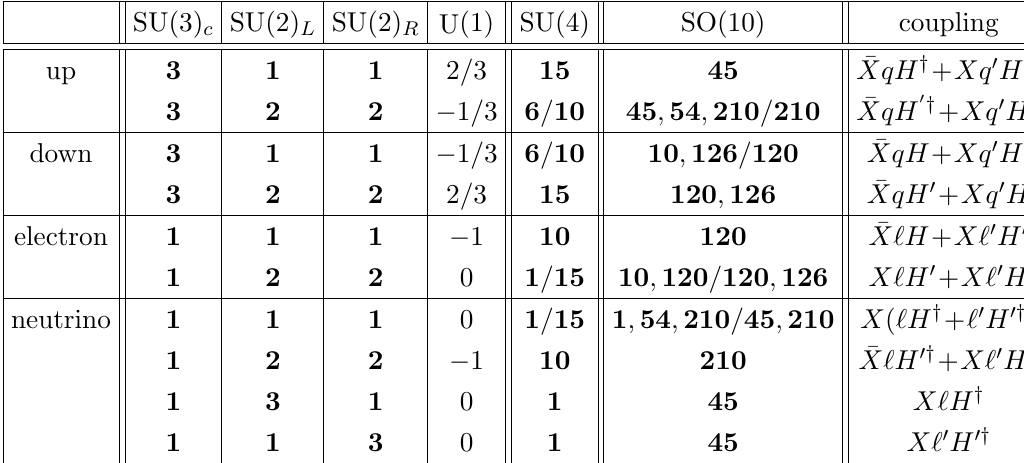
Table 3 . Possible X particles for generating Yukawa couplings in Model A. We also show the embedding of X into the Pati-Salam group SU(4) Here ~ y u;d;e are dimensionless (cid:13)avor matrices, with (cid:13)avor indices suppressed, while M u;d;e are mass